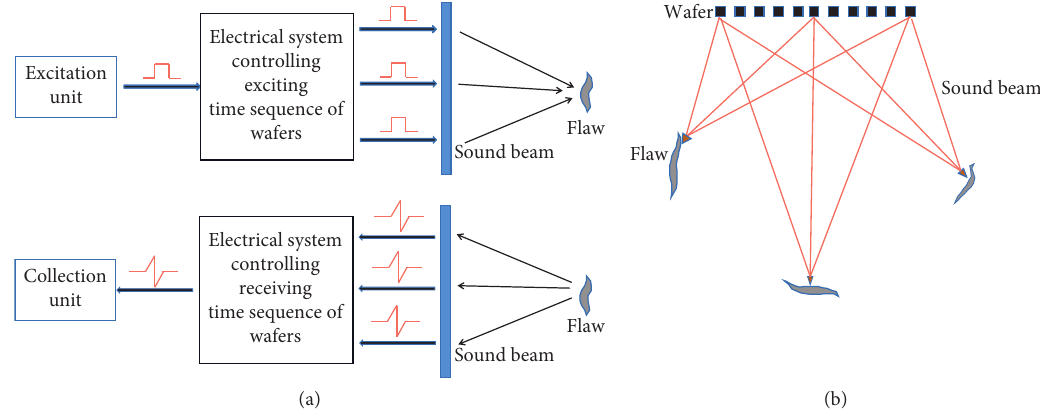
Figure 3: Principle of ultrasonic phased array scanning. (a) Exciting and receiving signals according to a certain time sequence. (b) Deflection of the sound beam.